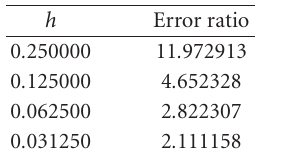
Table 3.3. Approximation of